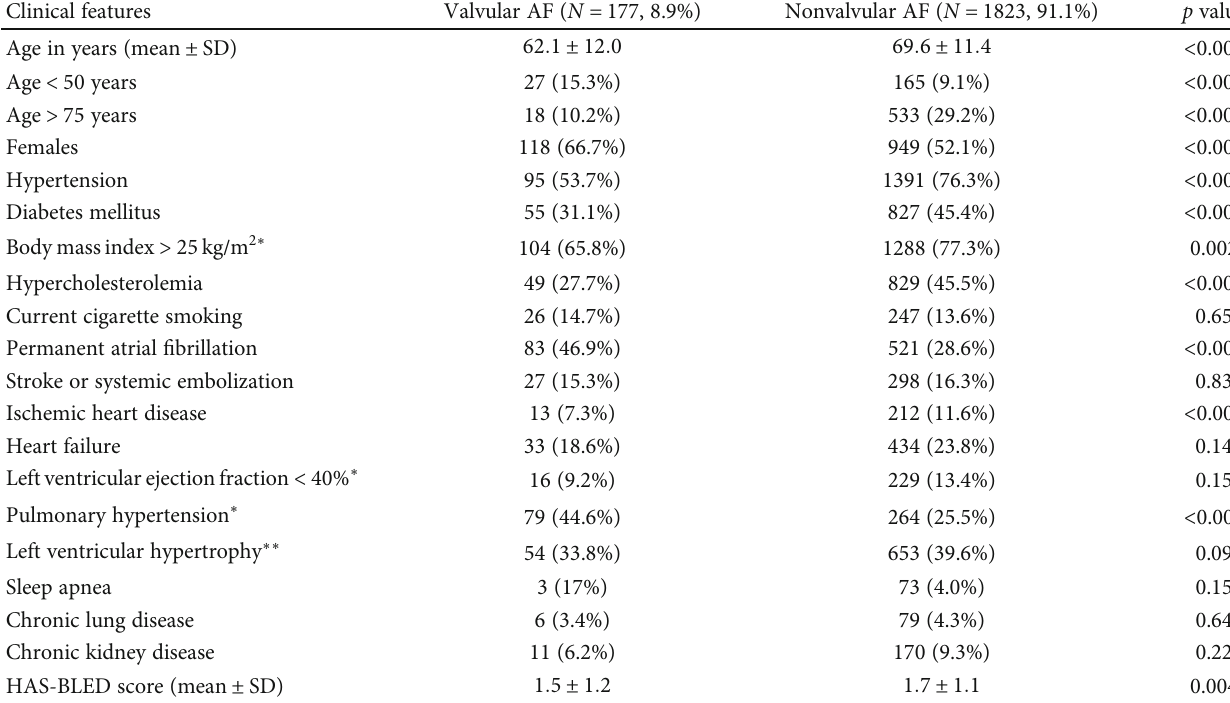
Table 1: Baseline clinical characteristics of 2000 patients with valvular and nonvalvular atrial fi brillation. Clinical